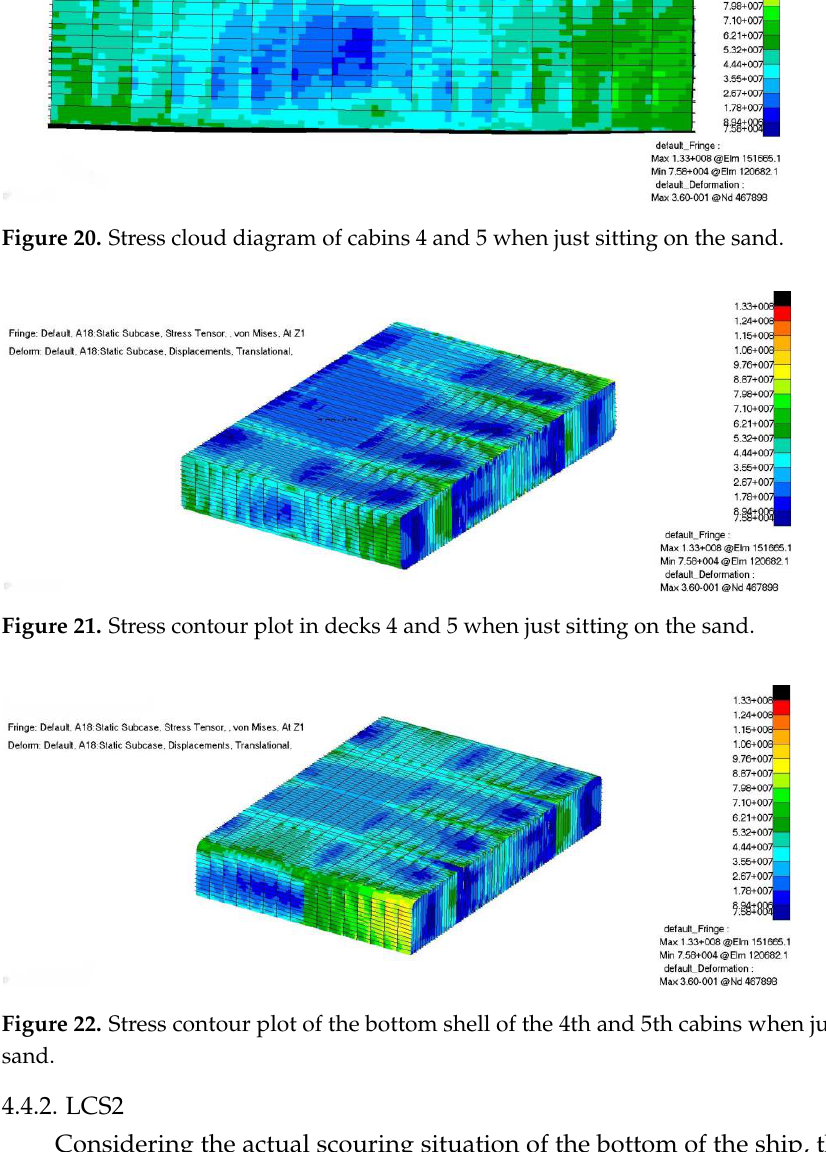
Figure 19. Deformation diagram of the hull structure when just sitting on the sand.